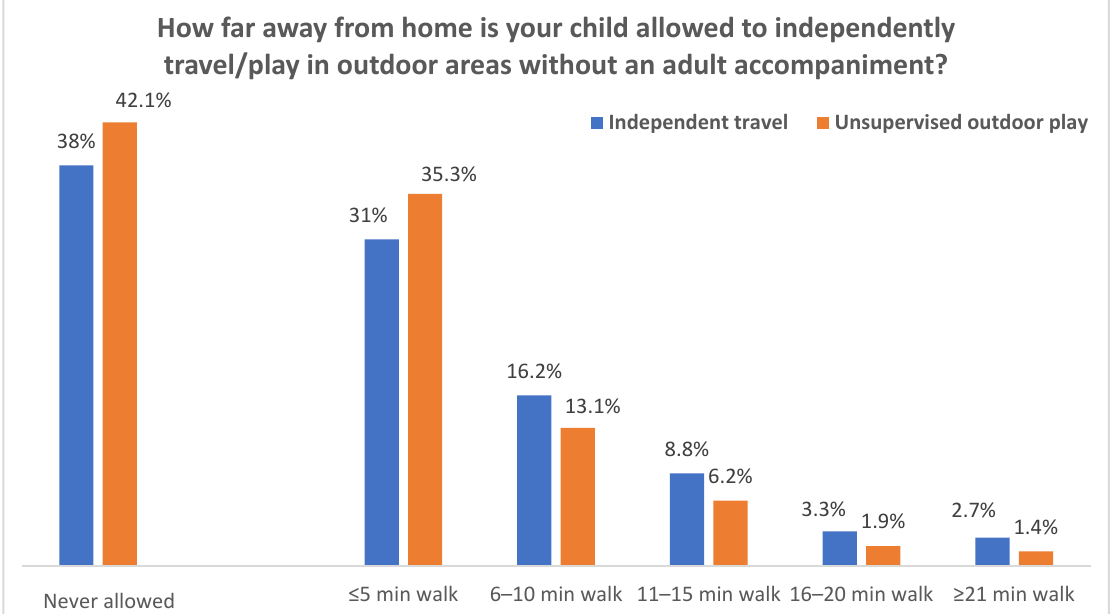
Figure 3. Parental license for independent travel and unsupervised outdoor play (second to fifth grade).